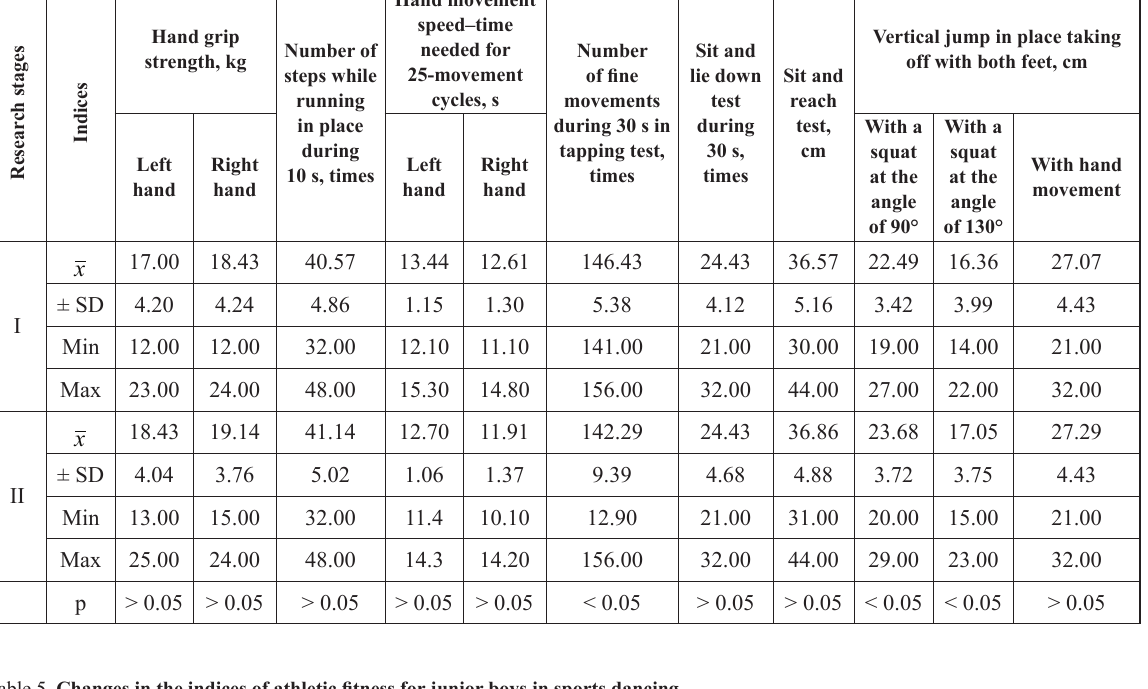
Hand movement speed–time needed for 25-movement cycles, s Left Right hand hand